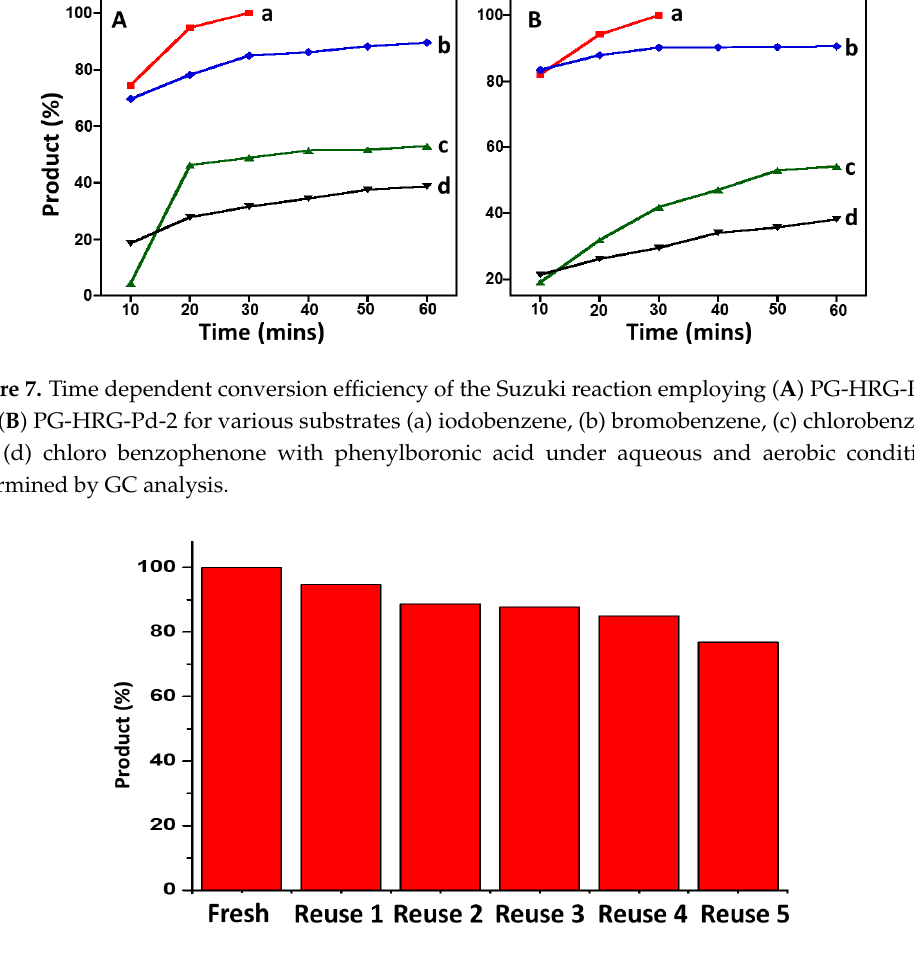
Figure 8. Graphical representation of conversion product obtained by the reuse of catalyst for the catalytic conversion of iodobenzene.